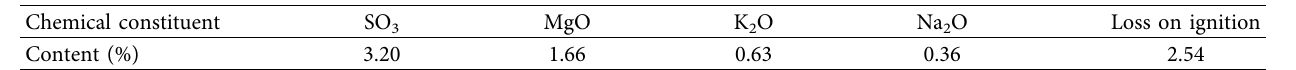
Table 2: Chemical composition of